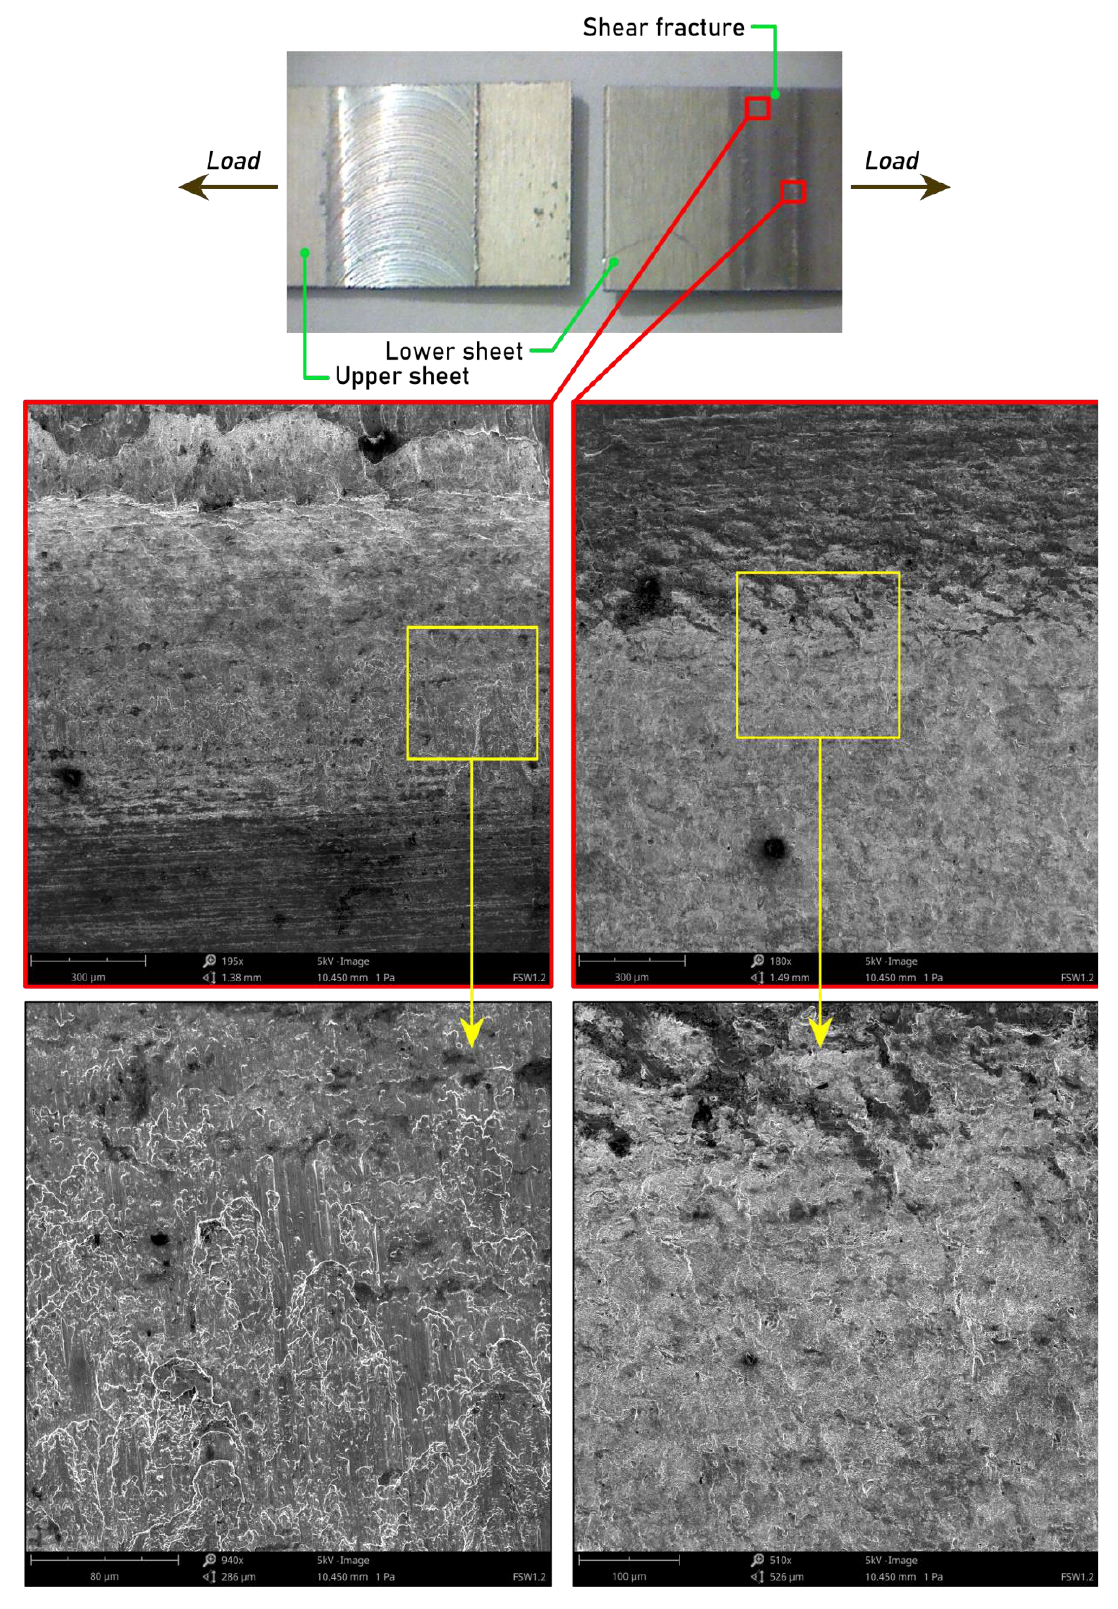
Figure 11. SEM images of a fracture surface of an FSW weld joint made using the following param- eters: pin length d = 1.1 mm, welding speed f = 400 mm/min, and tool rotational speed n = 1600 rpm.